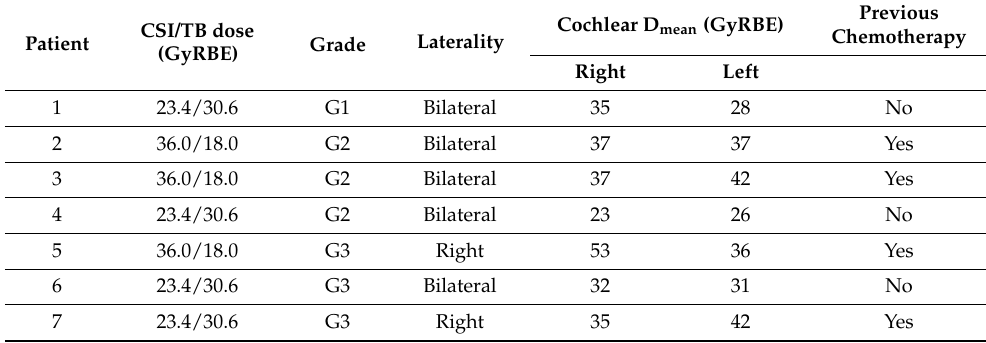
Table 6. Preliminary data on